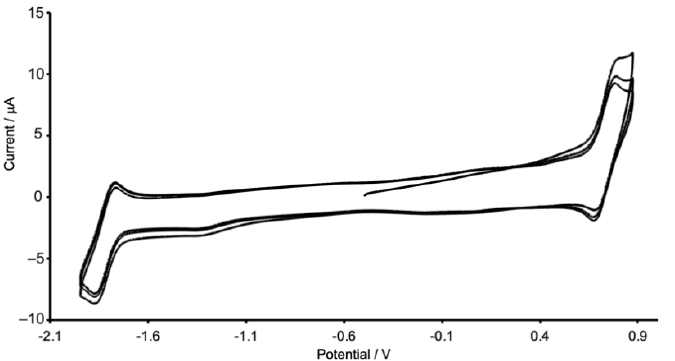
Figure 8. Three consecutive scans in the cyclic voltammogram of [Cu(POP)(biq)][PF 6 ] in CH 2 Cl 2 solution; see Table 3 for additional details.